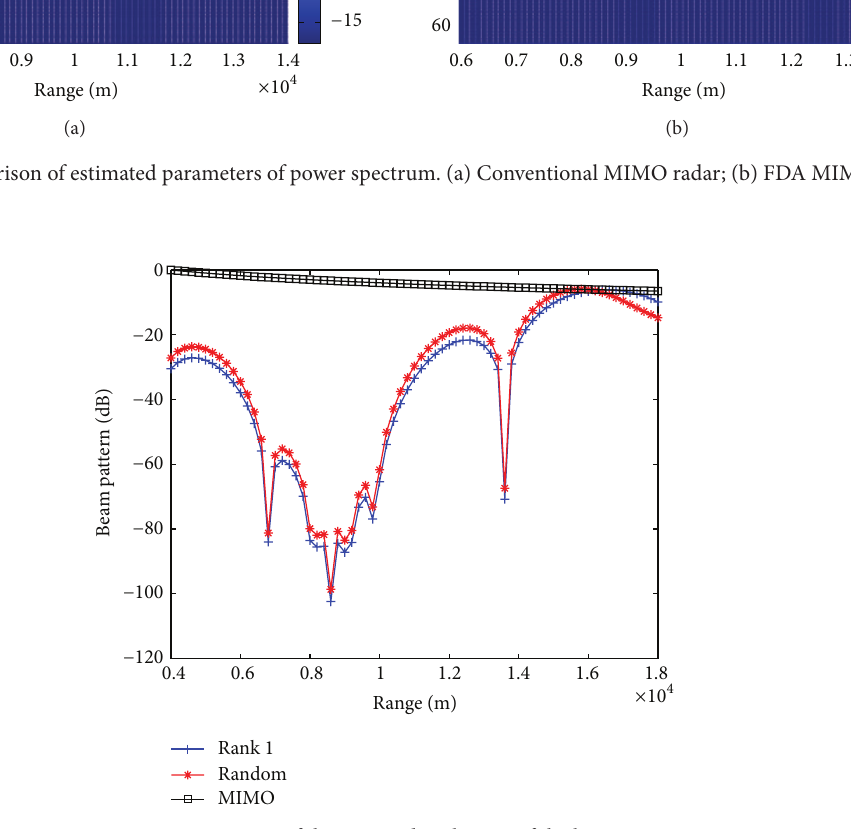
Figure 6: Comparison of the energy distribution of the beam